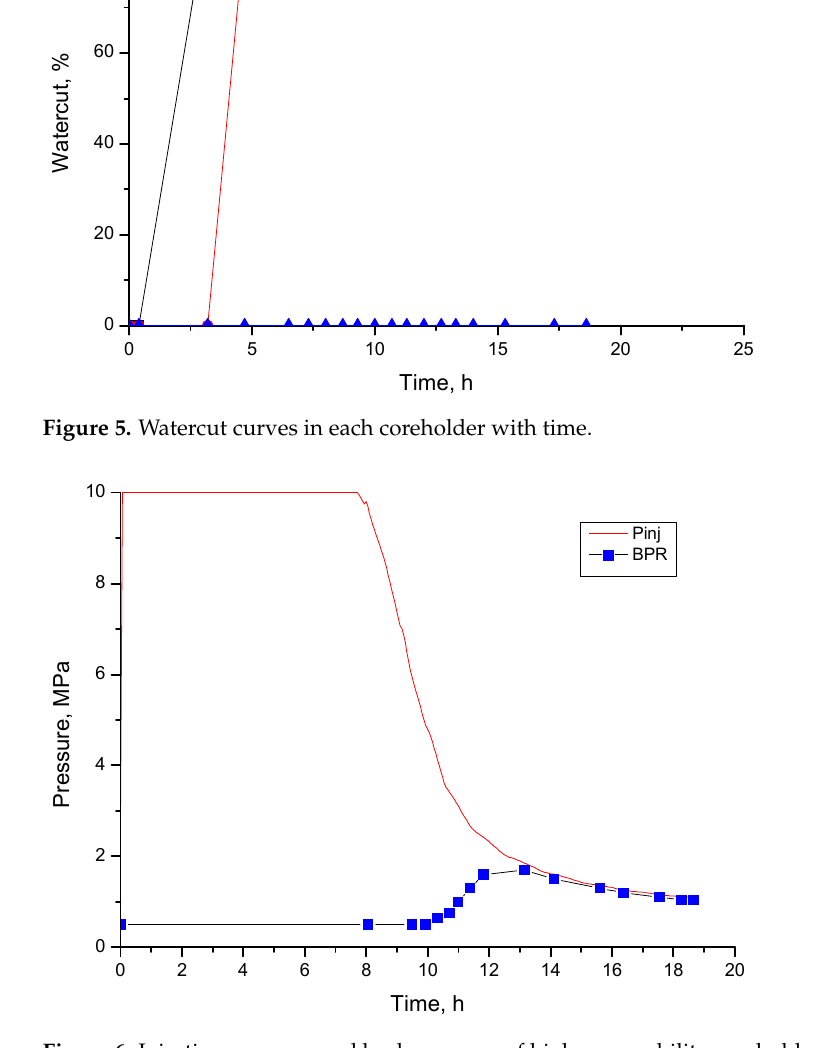
Figure 5. Watercut curves in each coreholder with time.